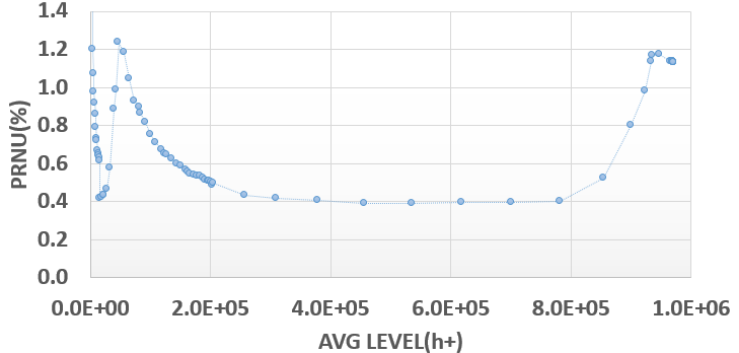
Figure 10. PRNU versus signal for holes.